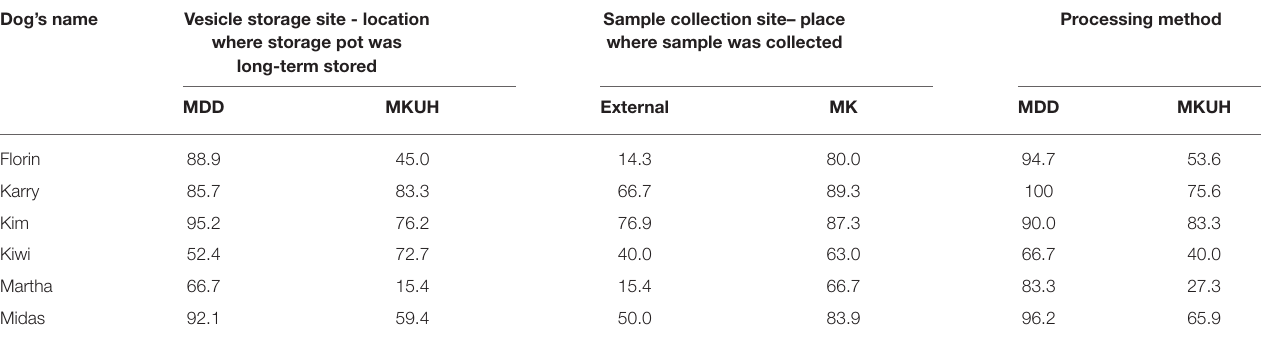
TABLE 4 | Percentage specificity of dog’s response when each factor is compared (hesitations without a full alert were classified as alerts and hence constituted a true positive on a target sample and a false positive on a control). Dog’s